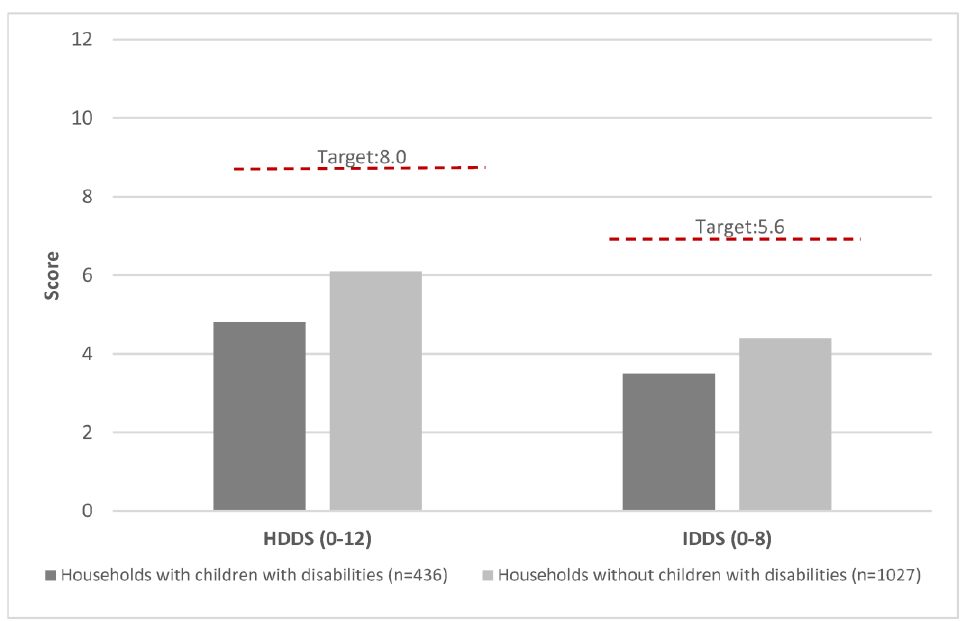
Figure 2. Household dietary diversity score and individual dietary diversity score among households with children with disabilities versus those without, Lusaka Zambia 2021. Based on individual items, families with a child with a disability were more likely to have eaten nshima and vegetables, compared to households without a child with a disability. All other food categories were more common in households without a child with a disability. See Table 2. Table 2. The percentage of participants who reported consumption of each food group using the household dietary diversity score in households with and without a child with a disability, Lusaka, Zambia